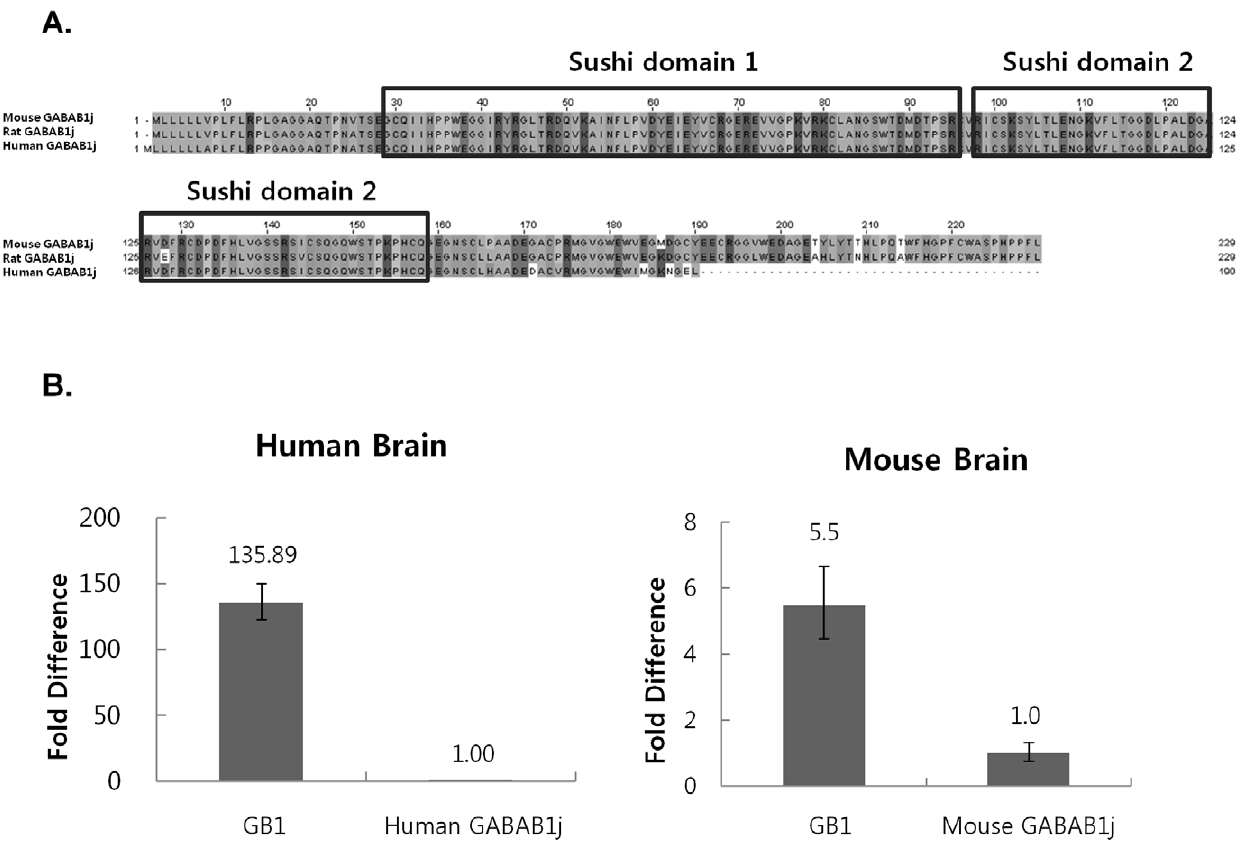
Figure 2. Sequences for human, mouse, and rat GABAB1j isoforms and relative expression levels. A. Sequence alignment of human, mouse, and rat GABAB1j showed a different C-terminal pattern in human GABAB1j. B. Human and mouse GABAB1j mRNA expression levels were measured with quantitative real-time PCR. GB1 primer and probe sets were used to detect most known major GABAB1 isoforms except GABAB1j. Human and mouse GABAB1j primer and probe sets were specific for only GABAB1j. GB1 expressions were shown as fold differences from human and mouse GABAB1j. Although a previous rat GABAB1j study indicated that GB1 and GABAB1j expression levels were similar, human and mouse GABAB1j expressions were lower than GB1. Mouse GABAB1j expression was 5.5 fold lower than GB1 expression, and human GABAB1j showed 135.89 fold lower expression. If the fold differences were compared, human GABAB1j expression level was much less (25 times) than mouse GABAB1j expression. Therefore, GABAB1j expressions vary across